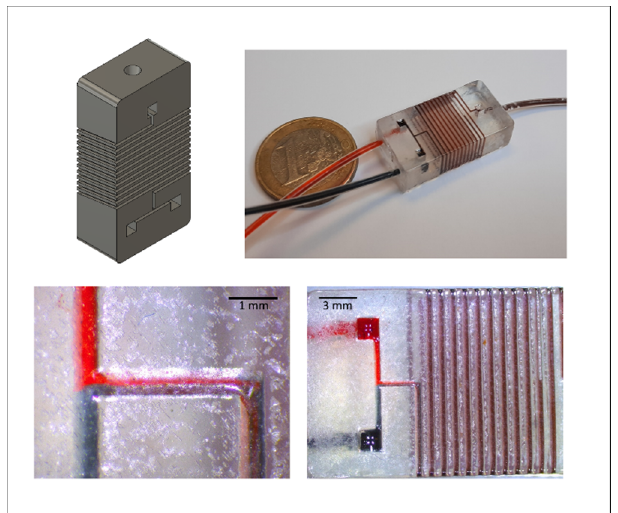
Figure 8. Meander structure as a serpentine mixer going the whole way around a cube, increasing the usable